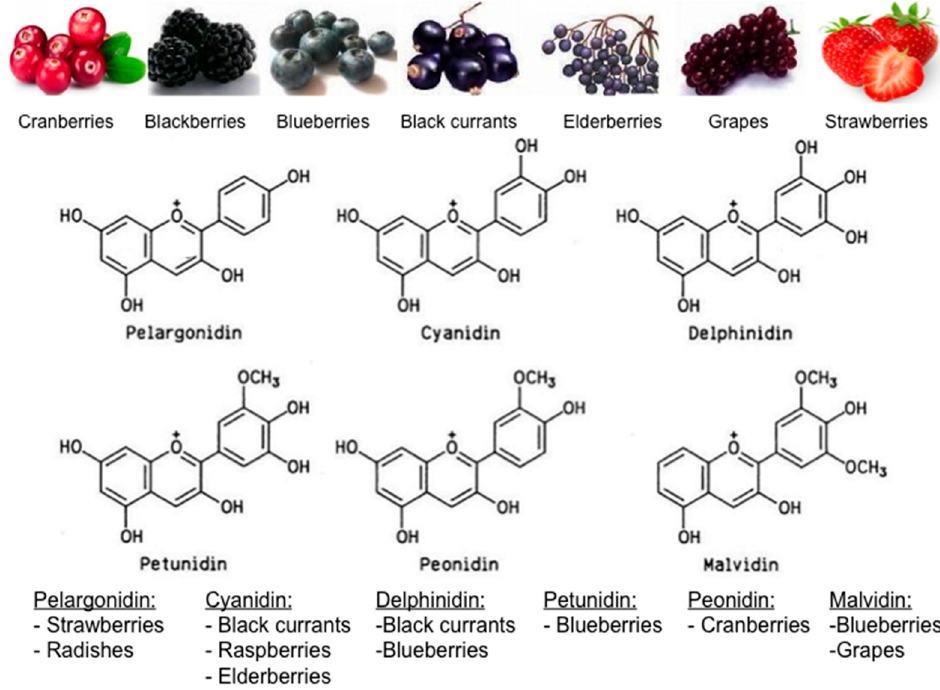
Figure 5. Major types of anthocyanins and characteristic examples of foods (berries) rich in the respective compounds (chemical structures produced via the eMolecules platform developed by eMolecules Inc., La Jolla, CA, USA).